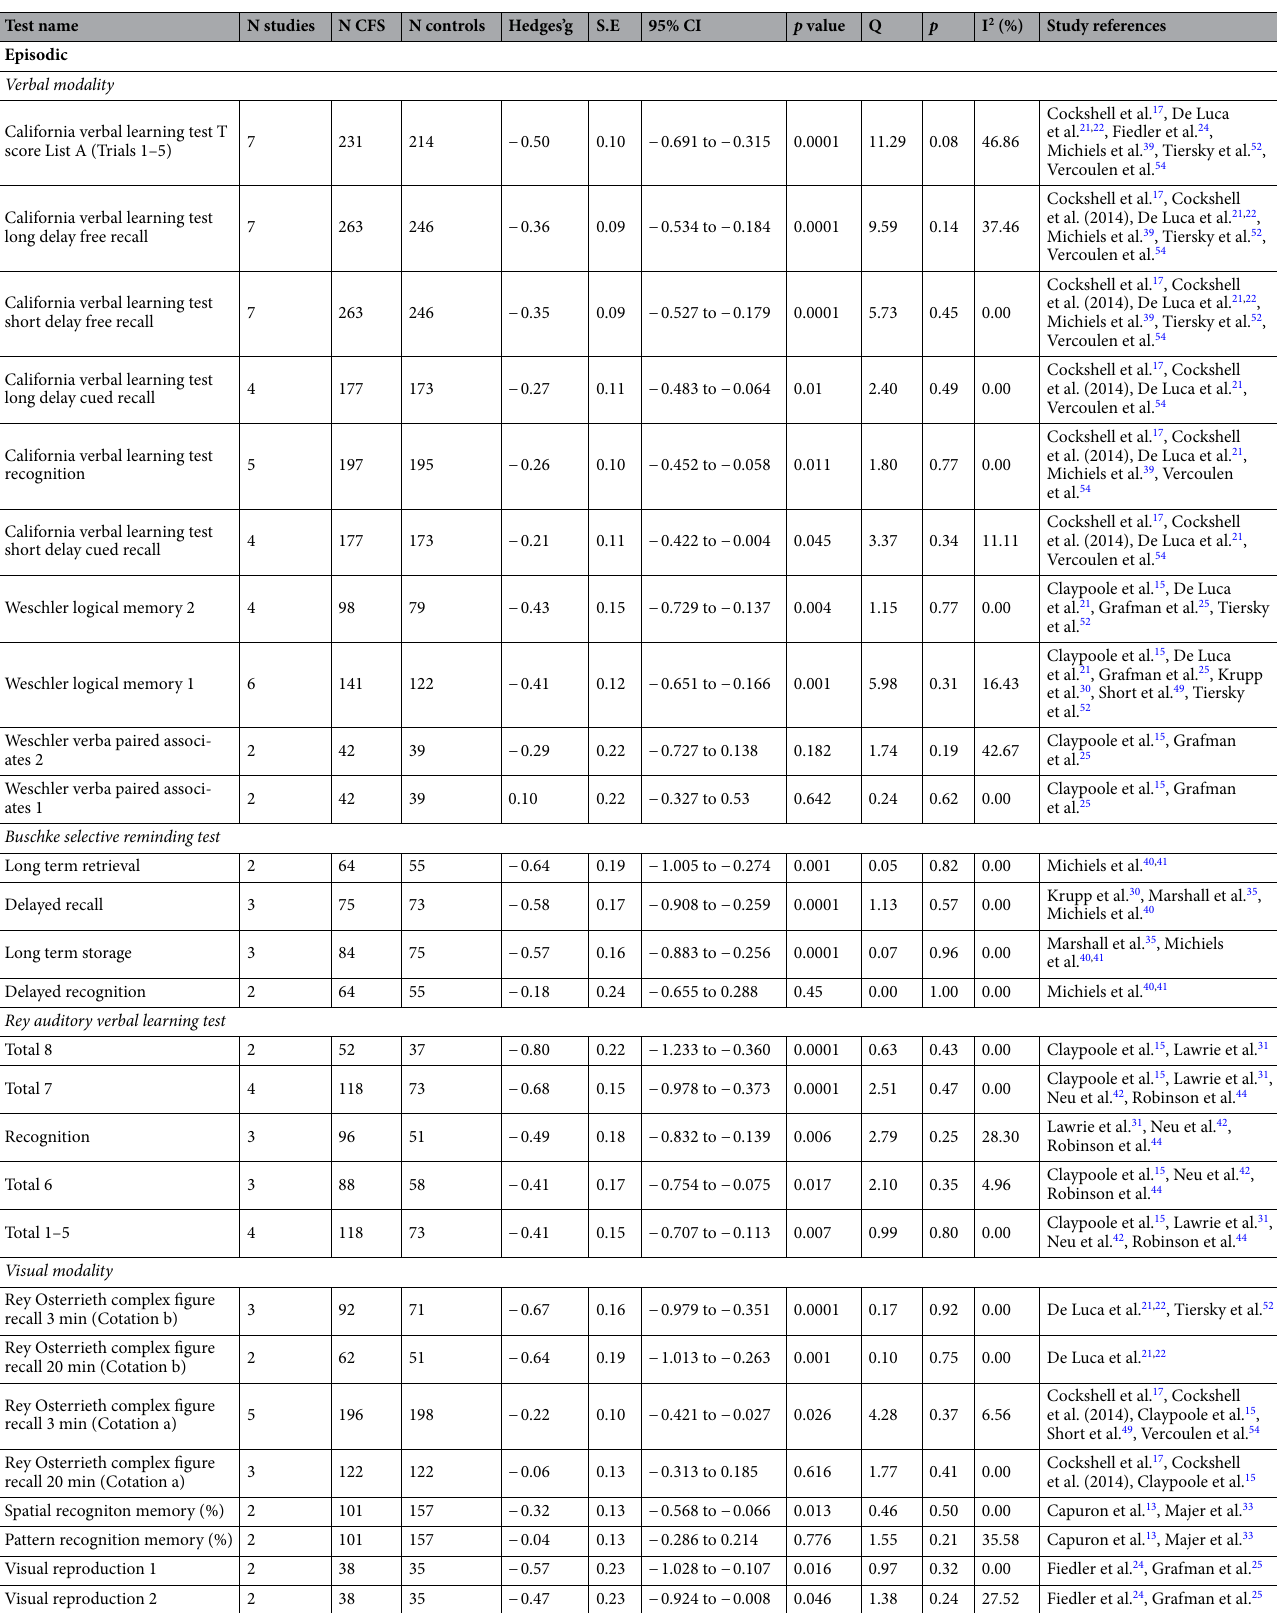
Table 8. Long term memory: Hedge’s g effect sizes for each test, in descending order. ME/CFS myalgic encephalomyelitis/chronic fatigue syndrome, N